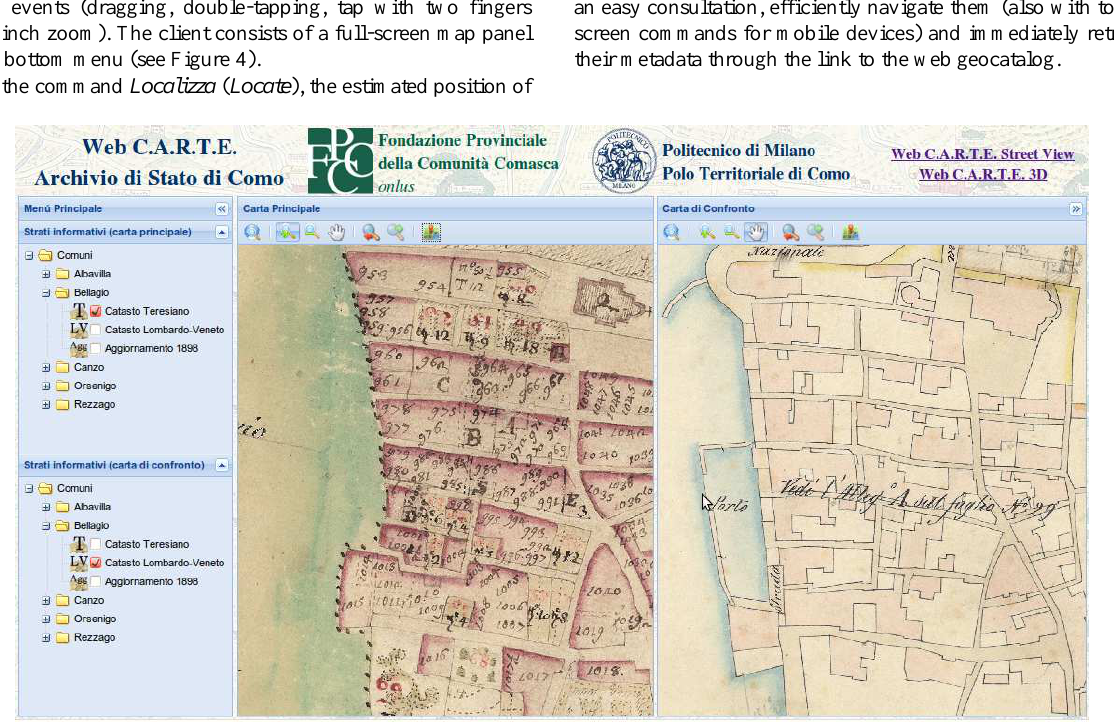
Figure 2. 2D visualization of Theresian (left) and Lombardo-Veneto (right) cadastral maps in the web client for computers